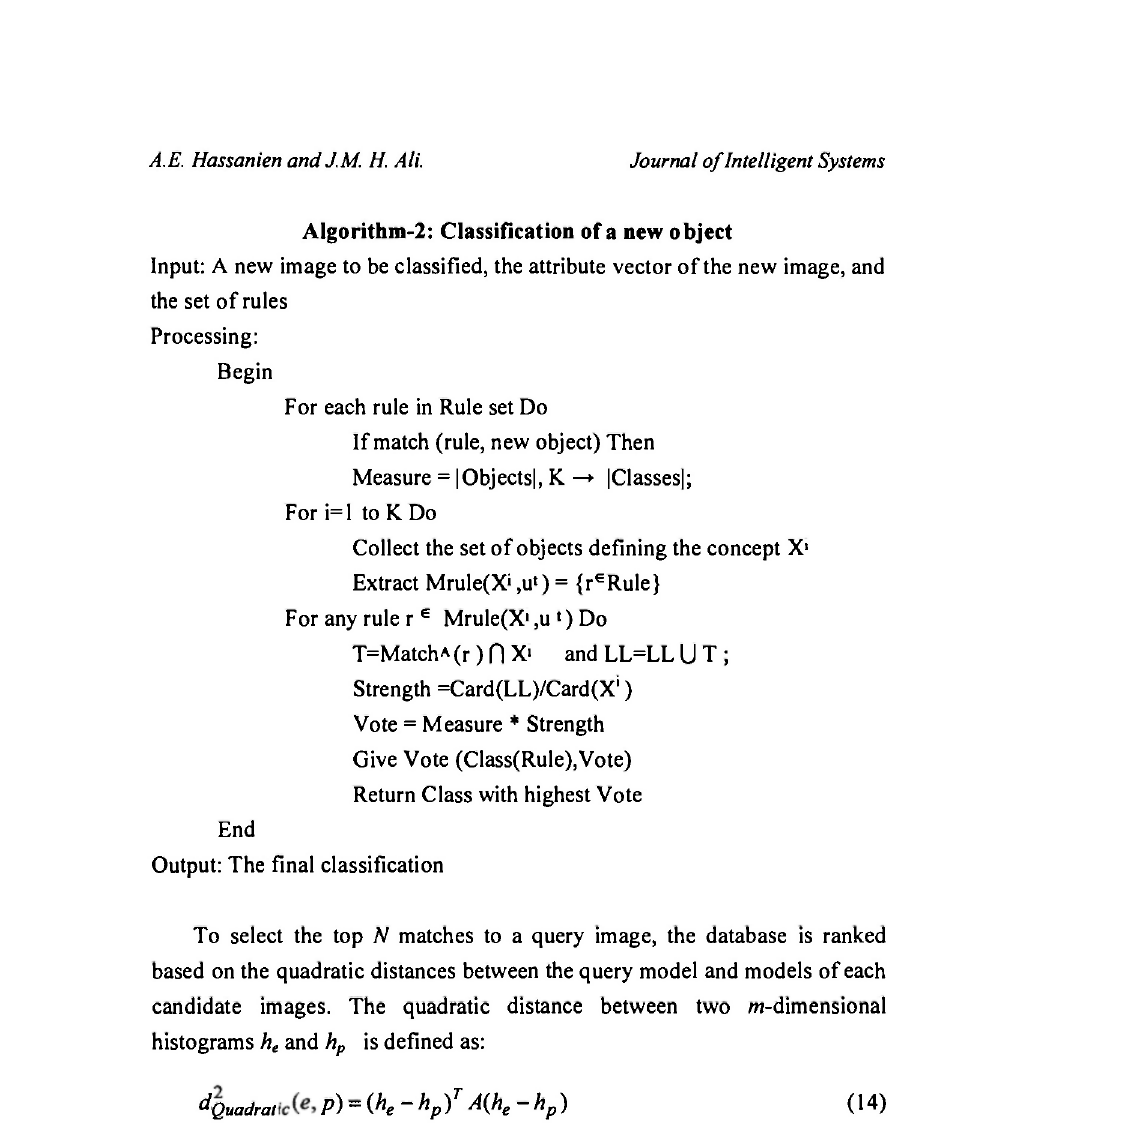
Algorithm-2: Classification of a new